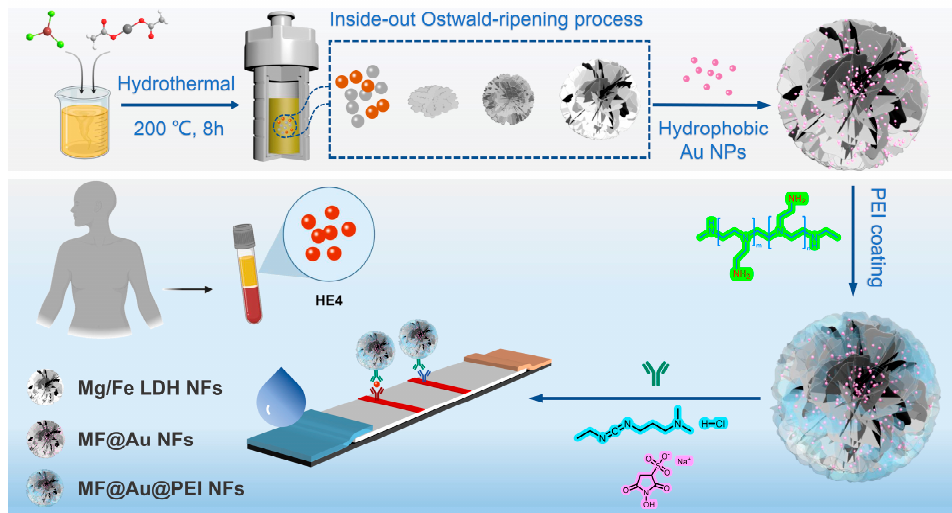
Figure 1. Schematic diagram of the preparation of high-density Au NPs-implanted Mg/Fe-LDH nanoflowers and detection process for MF@Au@PEI − LFIA.